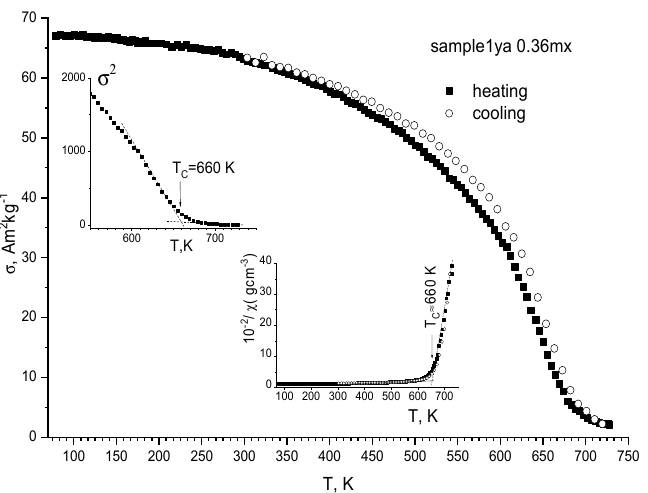
Figure 4. Temperature dependencies of the specific magnetization σ = f ( T ), obtained by the pon- deromotive method in the “heating-cooling” mode in the temperature range 80 K < T < 750 K in a magnetic field with induction B = 0.86 Tesla.